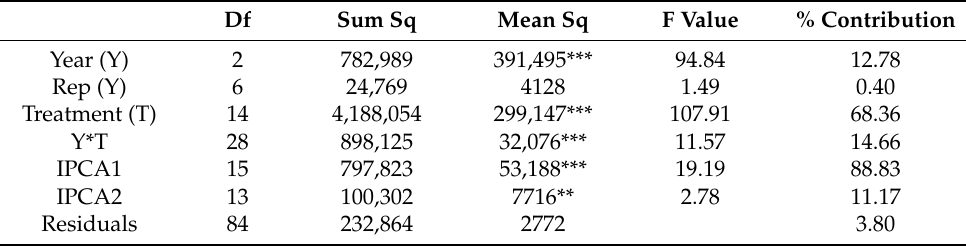
Table 6. Additive Main e ff ects and Multiplicative Interaction (AMMI) analysis of variance for seed yield for di ff erent treatment combinations involving hydrogel and nutrition. Df Sum Sq Mean Sq F Value % Contribution Year (Y) 2 782,989 94.84